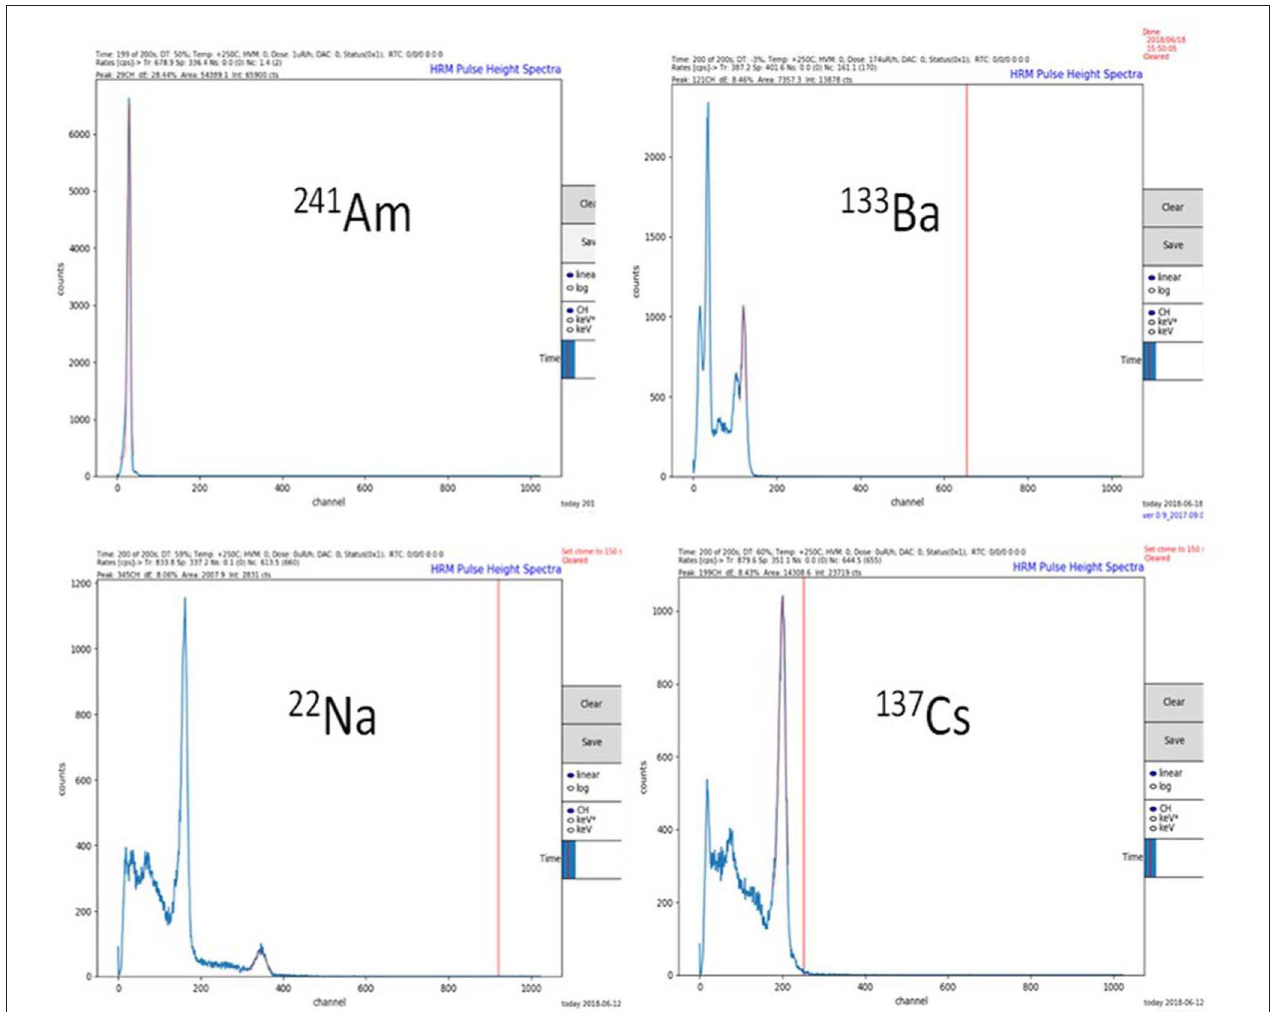
FIGURE 14 | Pulse height spectra recorded with the SPRD. Clockwise from upper left are spectra from 241 Am (60 keV), 133 Ba (81, 303 356 keV), 137 Cs (662 keV), and 22 Na (511 and 1.274 keV).